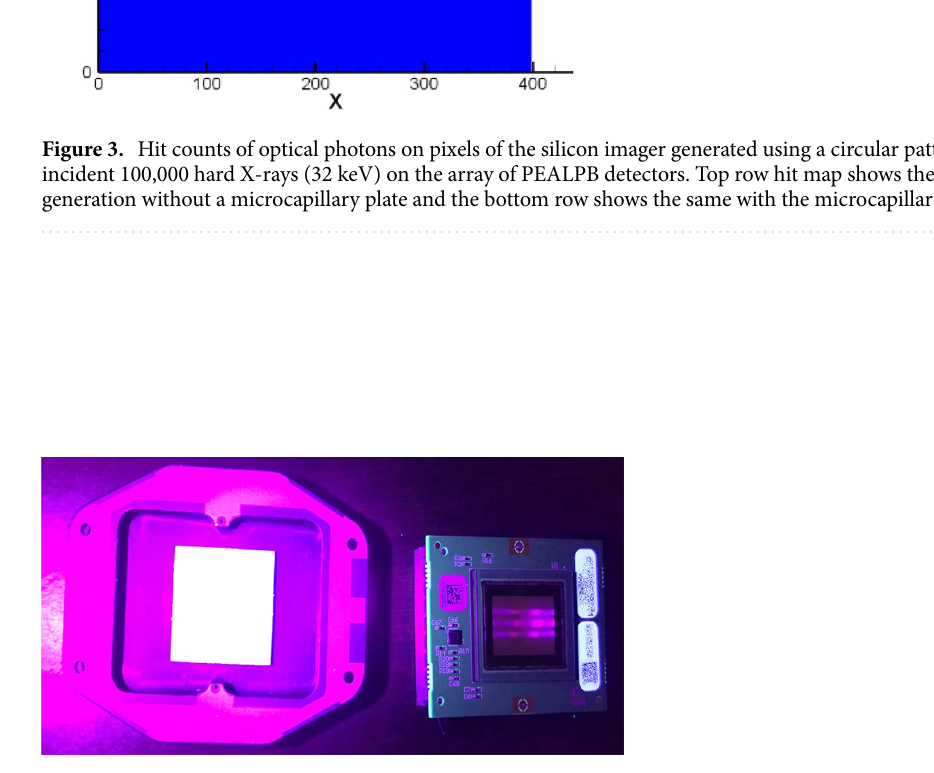
Figure 4. (Left) PEALPB detector attached to a metal plate that couples with the (right) CMOS